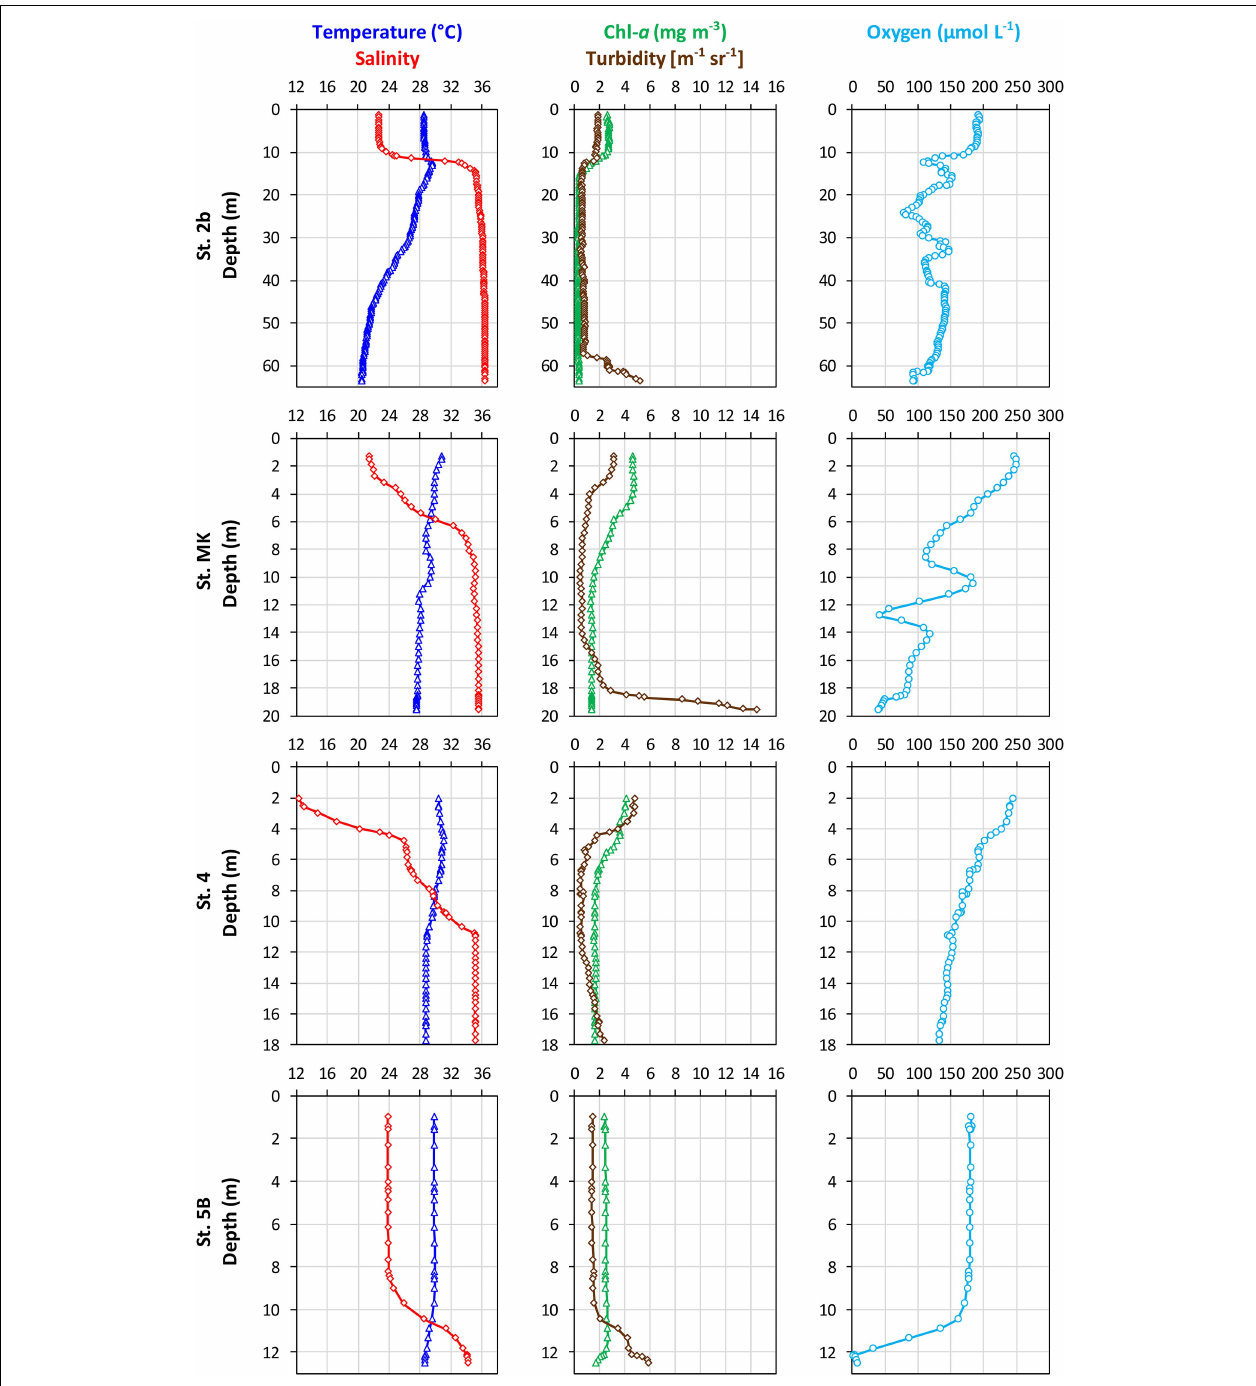
FIGURE 2 | Water column distribution of temperature ( ◦ C), salinity, Chl-a concentration (mg m − 3 ), turbidity (m − 1 sr − 1 ), and dissolved O 2 concentration ( µ mol L − 1 ) measured in situ with the CTD/Rosette at the four stations on the Louisiana shelf (in July-August